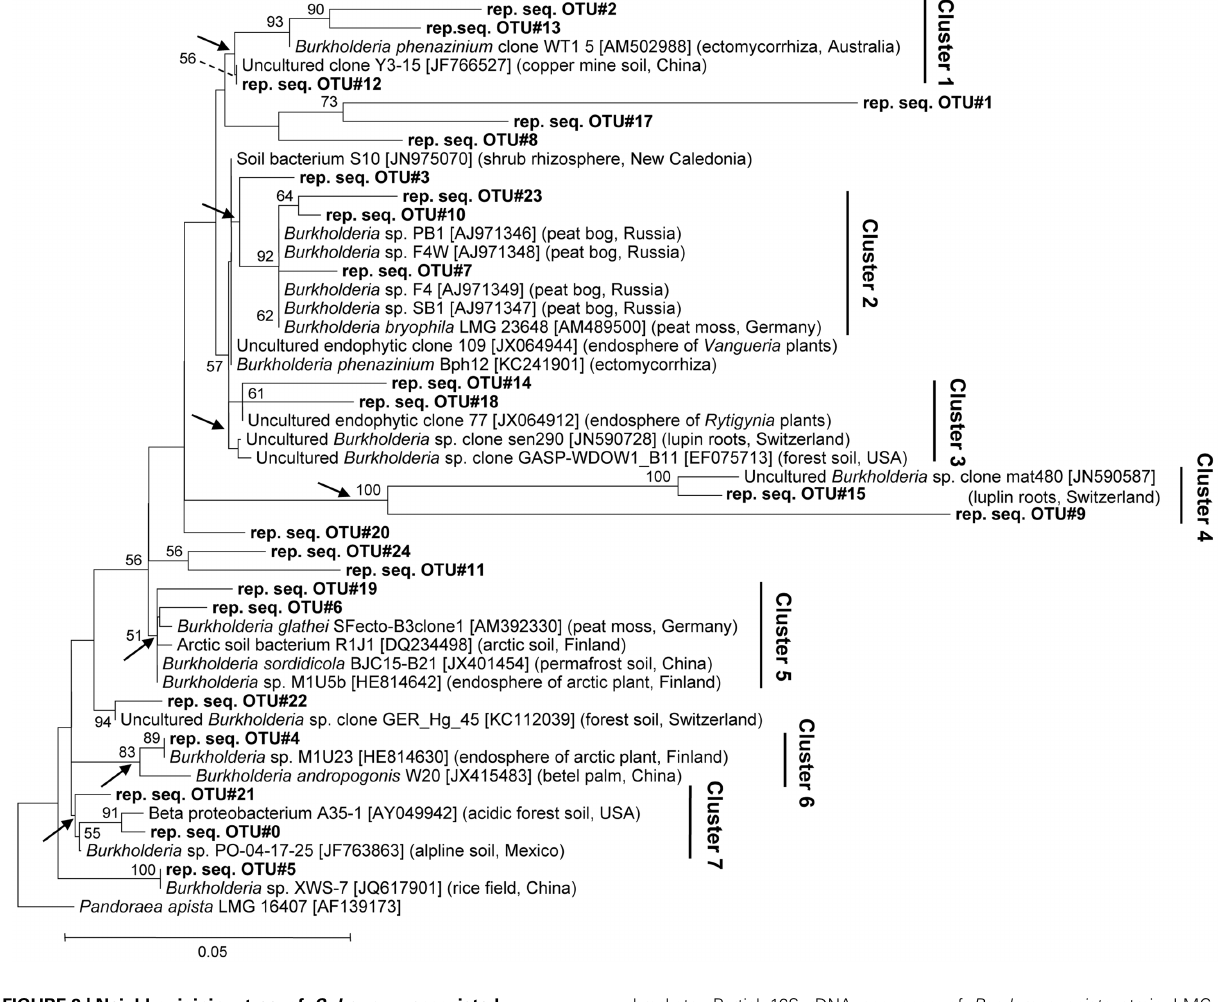
FIGURE 2 | Neighbor-joining tree of Sphagnum -associated burkholderial communities. Phylogenetic relationships are shown for 16S rDNA sequence representing burkholderial OTUs (97%) (bold) and the nearest ecologically related reference sequences. The isolation sources and accession numbers of reference sequences are shown in